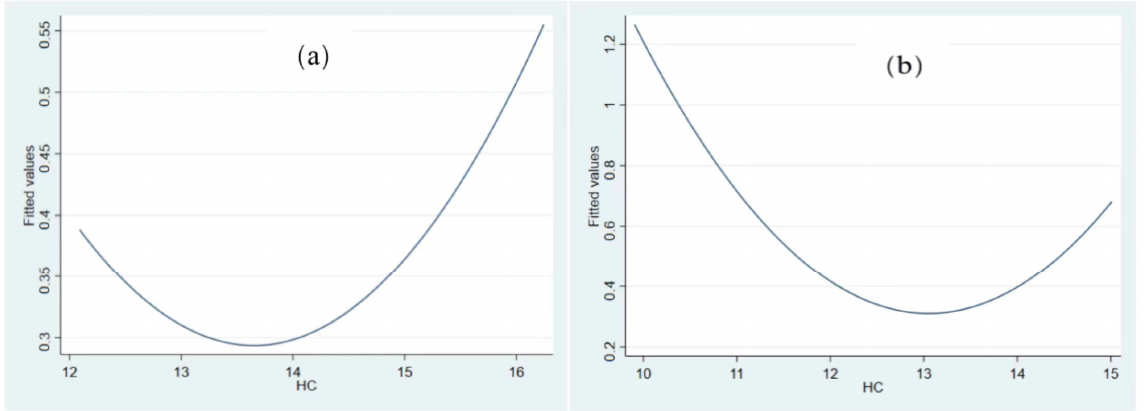
Figure 6. Fitting diagram of HC and GEE for different city size. ( a ) Fitting diagram of HC and GEE in large cities; ( b ) fitting diagram of HC and GEE in small and medium cities.